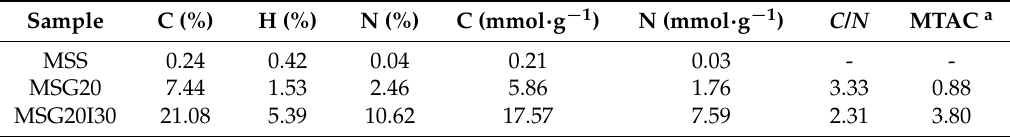
Table 1. Elemental analysis of the samples